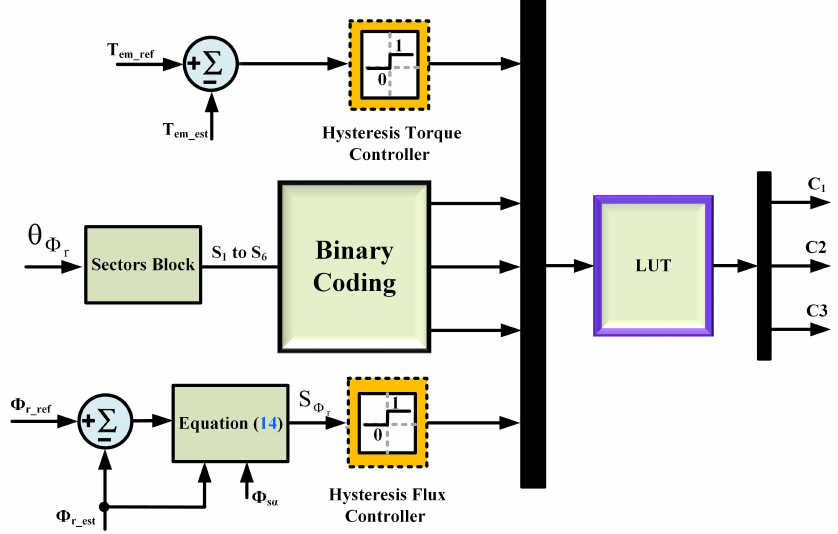
Figure 1. The block diagram of DTRFC scheme.